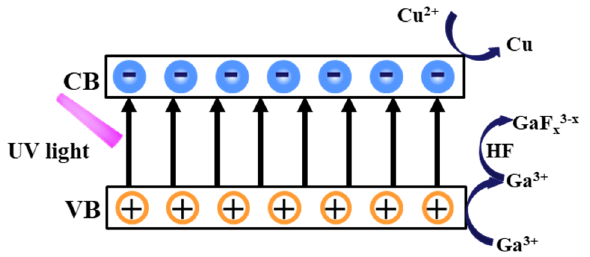
Figure 2. Schematic diagram of the MacEtch mechanism of GaN films.